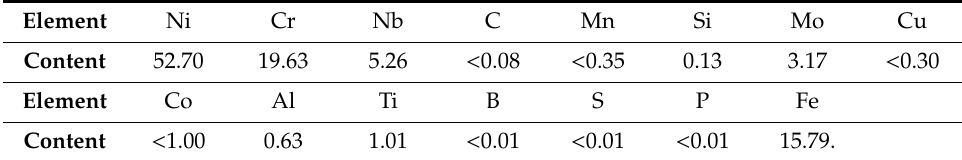
Table 1. Chemical composition of the investigated GH4169 alloy